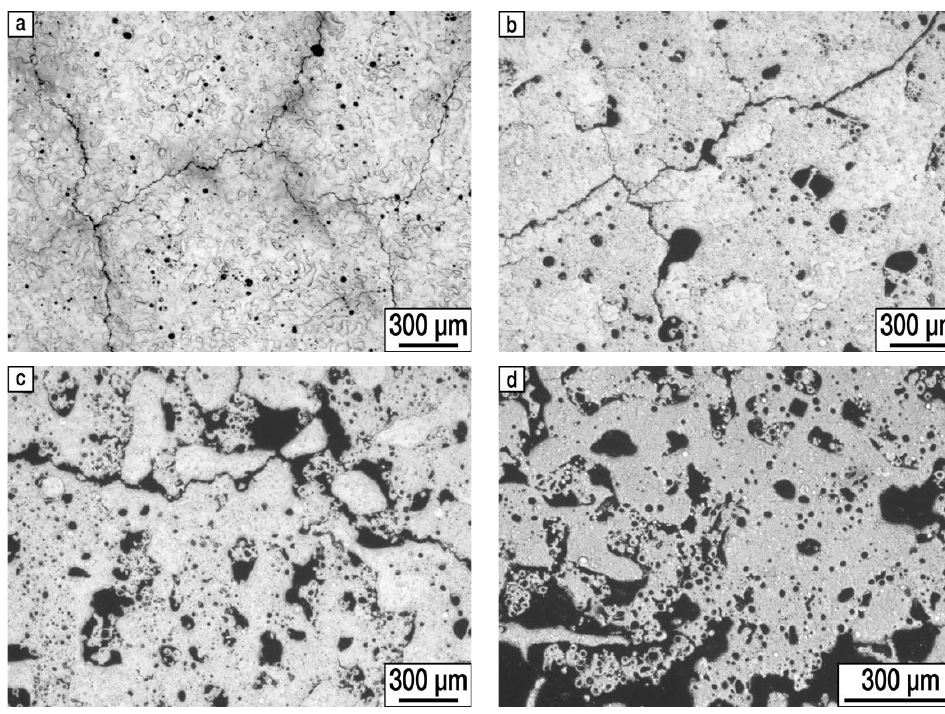
Figure 10. Images of the W-5Ni-2Fe SLM samples’ structure produced at different laser scanning velocities: 300 mm/s ( a ); 500 mm/s ( b ); 700 mm/s ( c ); 900 mm/s ( d ) under constant laser power 700 W.